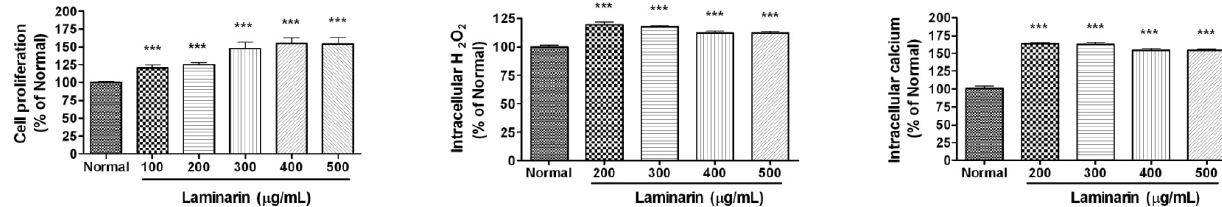
Figure 2. Effects of laminarin on the cell proliferation, calcium and, hydrogen peroxide production in RAW 264.7 mouse macrophages. Cells were incubated with laminarin for 24 h. Cell proliferation was evaluated by the MTT assay. Intracellular calcium was measured with Fluo-4 calcium assay. Intracellular hydrogen peroxide was measured with a dihydrorhodamine 123 assay. The normal group (Normal) was treated with medium only. Values are the mean + SEM of three independent experiments. *** p < 0.001 vs. Normal.